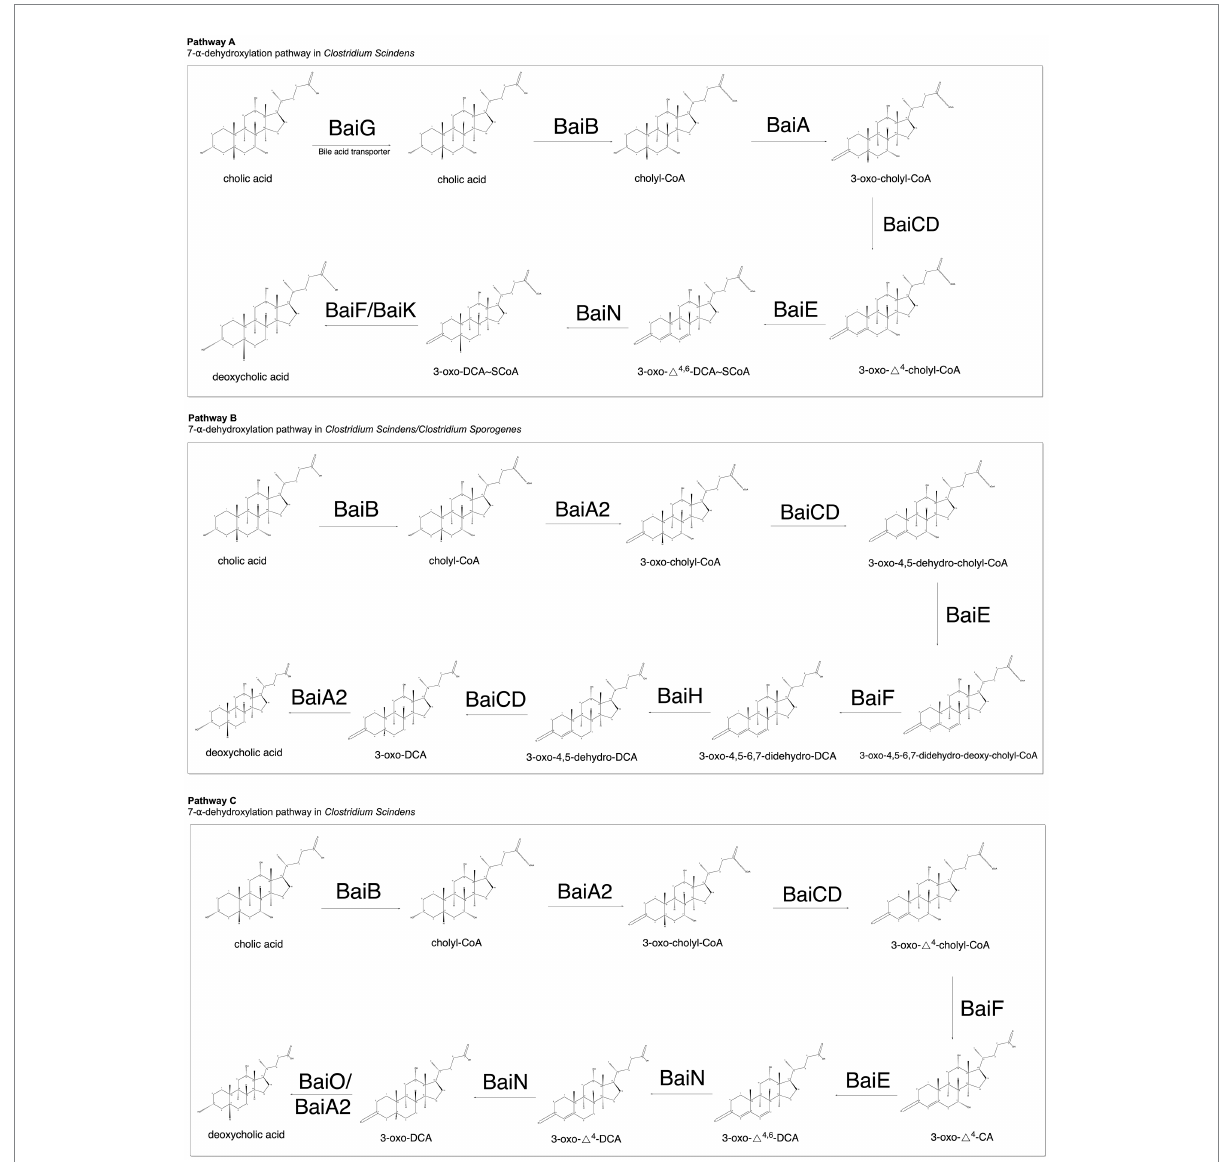
FIGURE 1 Summary of proposed 7- α -dehydroxylation pathways. Studies presented in each pathway are cited accordingly. Pathway A (Ridlon et al., 2006, 2010, 2014, 2020; Ridlon and Hylemon, 2012), Pathway B (Funabashi et al., 2020), and Pathway C (Guzior and Quinn,